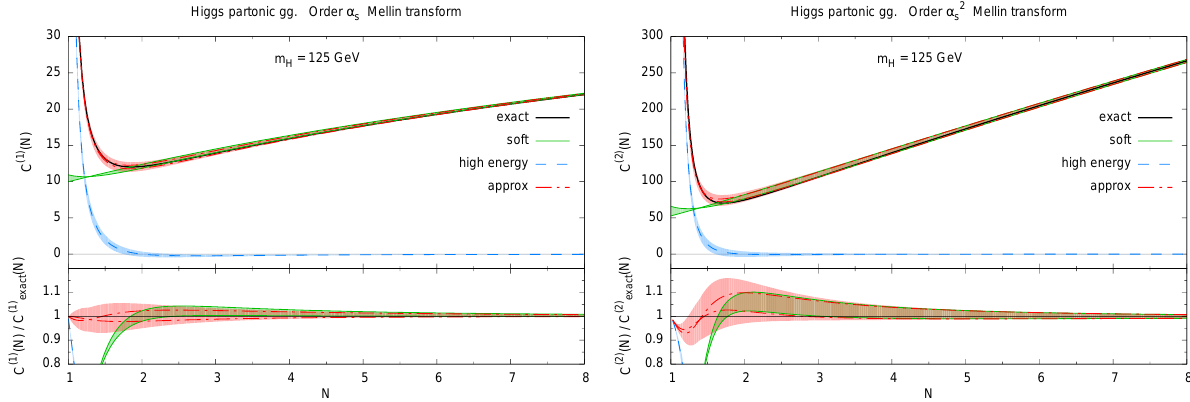
Figure 1. Comparison of the NLO (left) and NNLO (right) exact coe ffi cient functions to their soft, high-energy and combined approx-